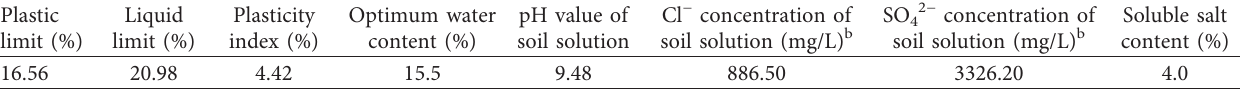
Table 1: Physical properties of saline soil.